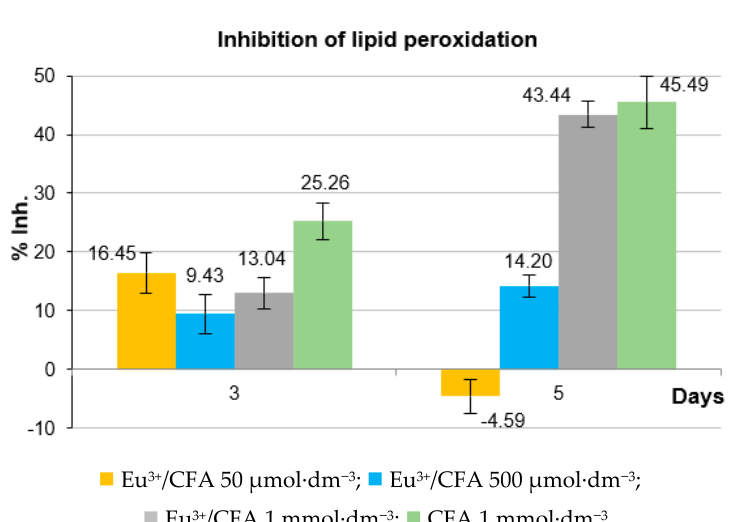
Figure 12. Antioxidant activity assays of CFA and Eu-CFA at indicated concentrations: ( a ) percentage of inhibition of ABTS • + cation radicals; ( b ) results of CUPRAC assays expressed as Trolox equivalents [ μ mol ∙ dm − 3 ]; ( c ) evaluation of the reducing ability by FRAP assay; ( d ) percentage of inhibition of lipid peroxidation by Eu 3+ /CFA complex at the concentrations of 50, 500 and 1000 μ mol dm − 3 . Mean values from three independent experiments ± SD are shown.